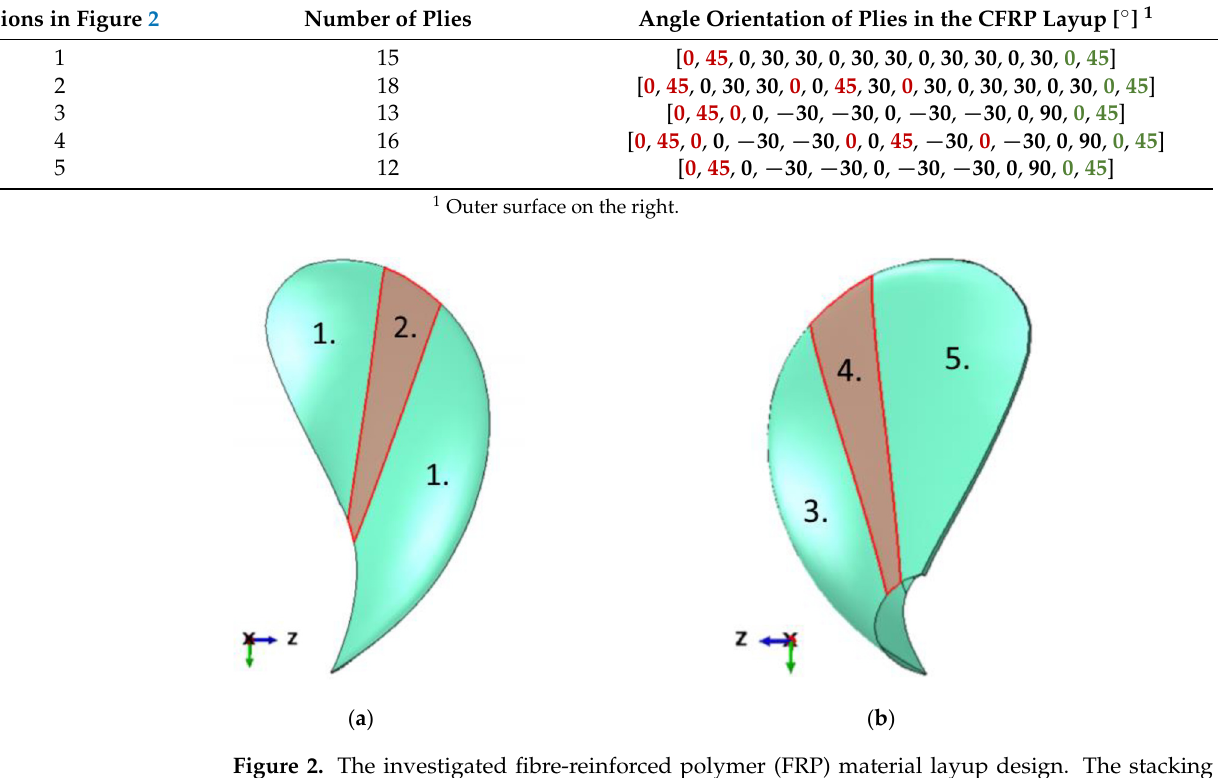
Table 1. Layup of the design in Figure 2. The colours indicate the different CFRP plies. The red colour is for backing plies, black is for UD plies, and green is for surface plies. The 0 ◦ orientation is in the green Y direction in Figure 2. Regions in Figure 2 Number of Plies Angle Orientation of Plies in the CFRP Layup [ ◦ ] 1